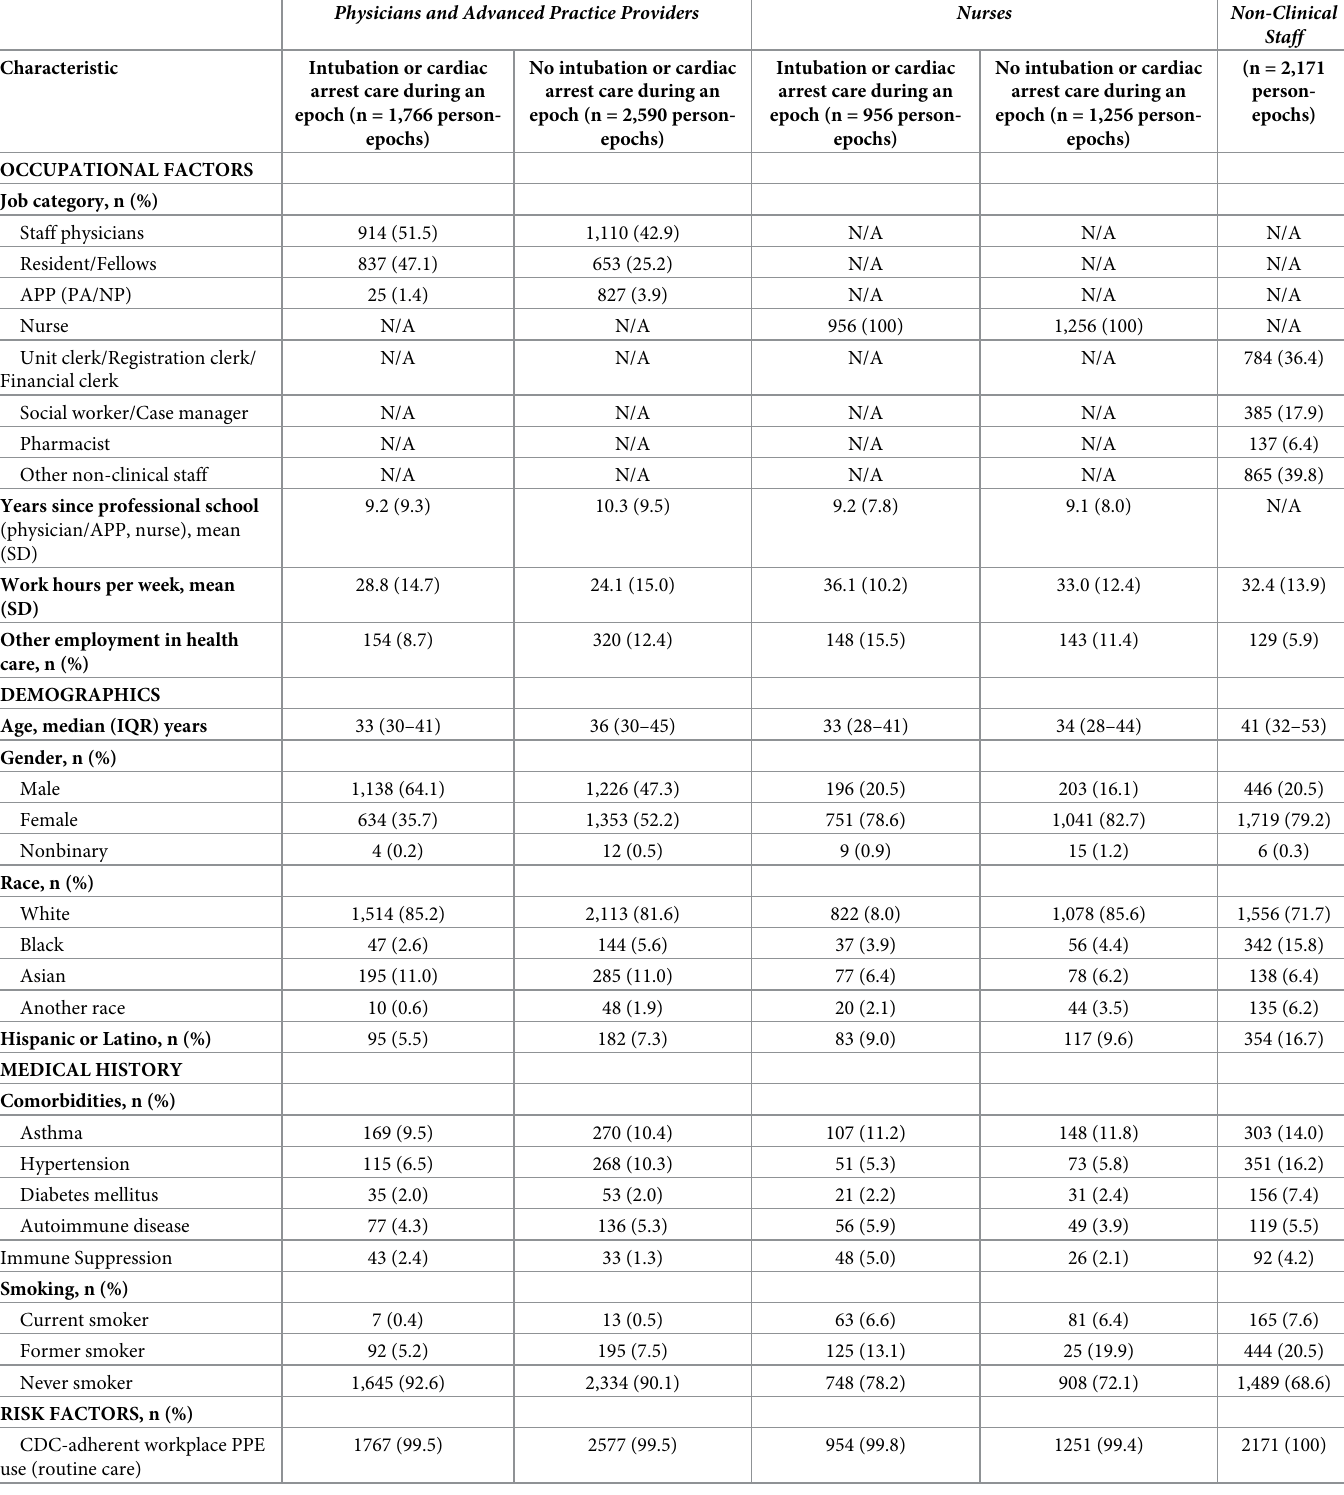
Physicians and Advanced Practice Providers